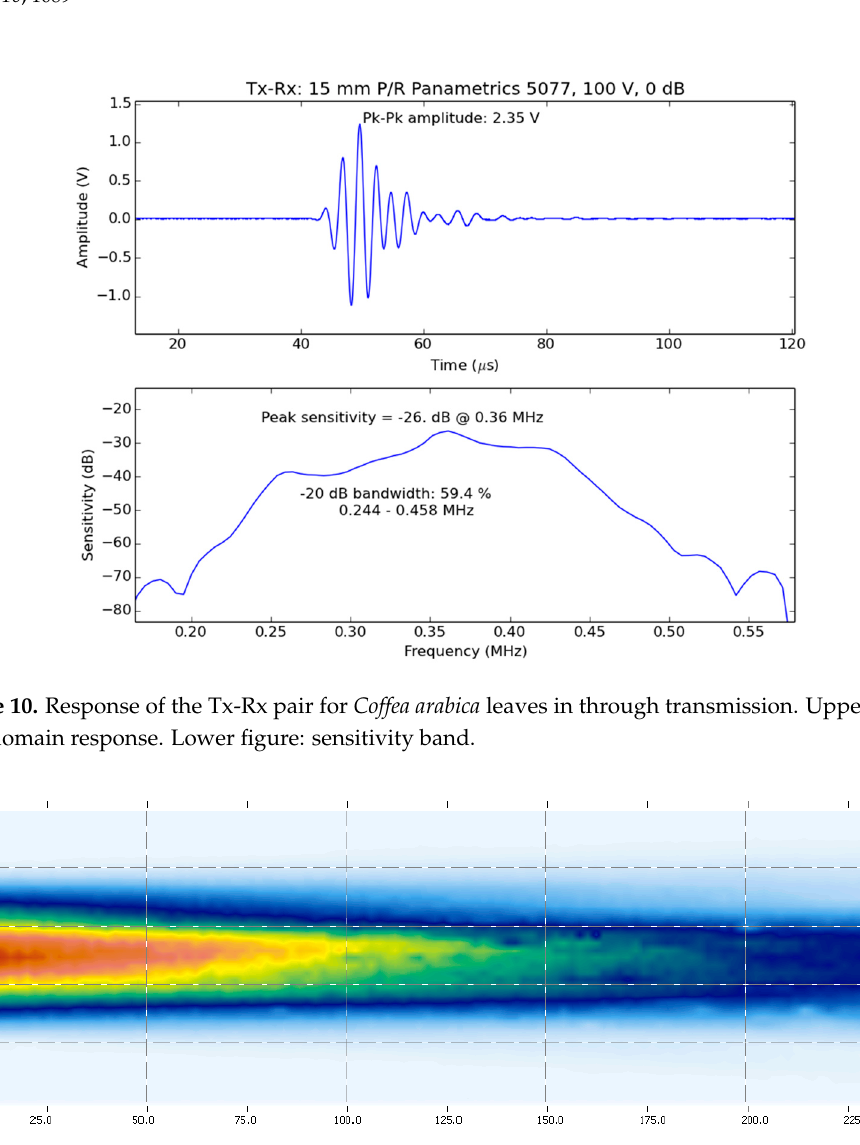
Figure 11. Acoustic field of the transducers for Coffea arabica.